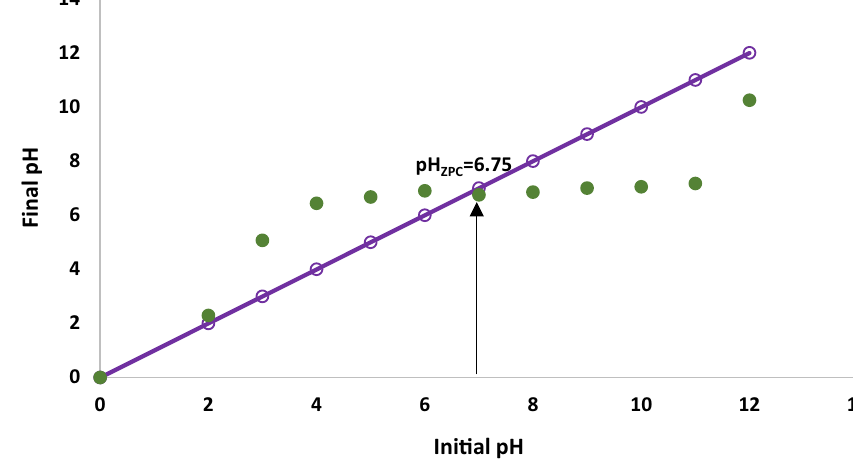
Fig. 3 Effect of pH on zeta potential of the S. platensis